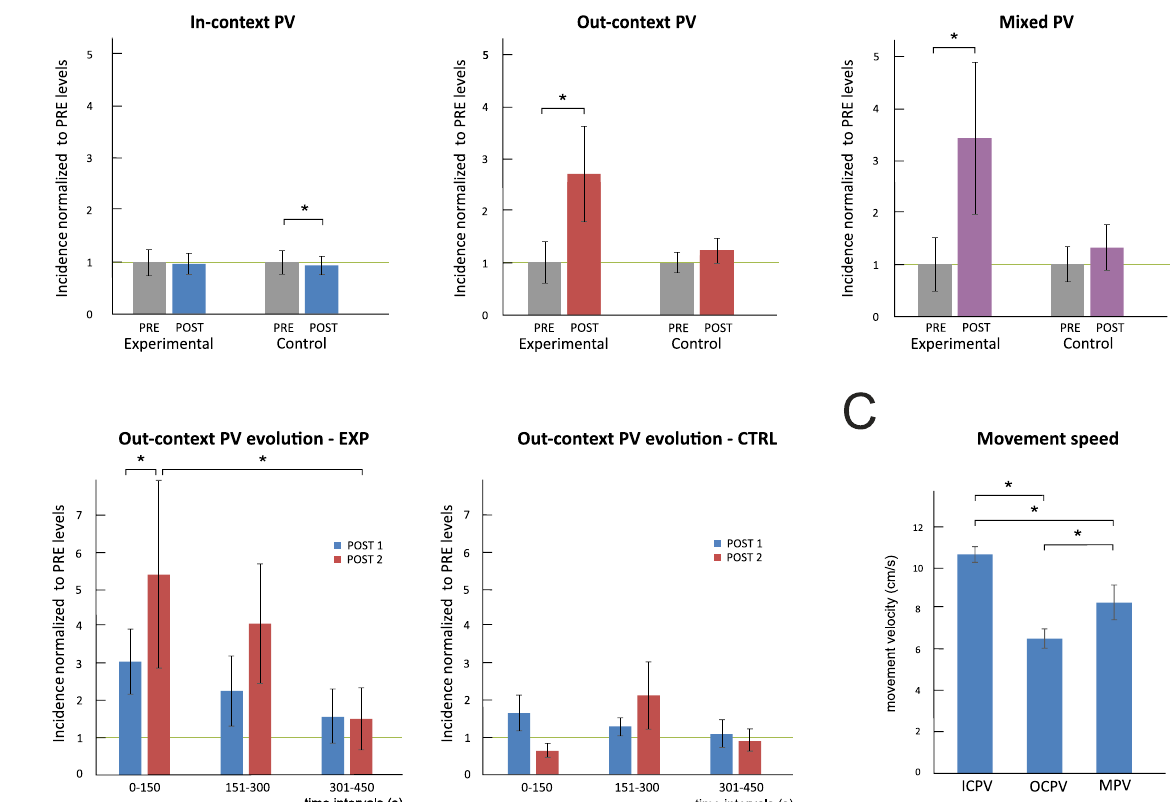
Figure 3. Incidence of in-context, out-context and mixed activity patterns. ( A ) Relative changes in incidence of all the categorized activity patterns across the experimental and control group. All values are normalized to the respective PRE-teleportation sessions baseline (green line). ( B ) Evolution of out-context activity patterns incidence within both POST sessions, divided into three 150-s intervals. The emergence of OCPV was high at the beginning of the session and decreased gradually in the experimental group with the teleportation session experience. ( C ) Average subject’s movement velocity during each identified activity pattern. * indicates p <